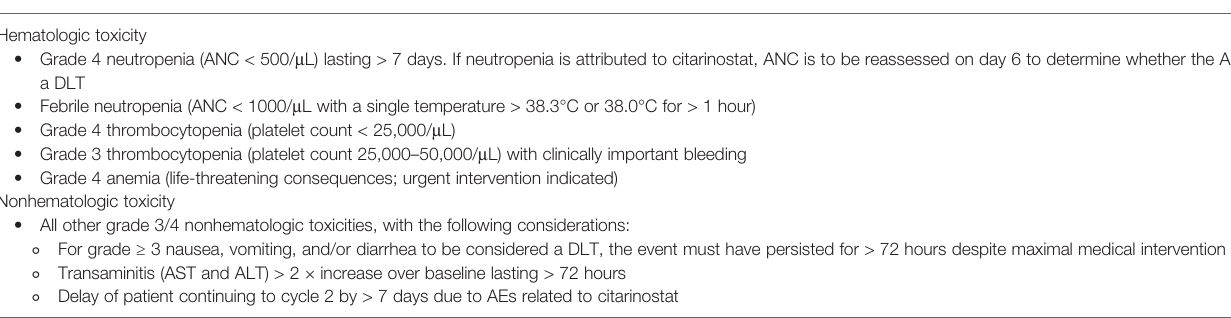
TABLE 1 | DLT de fi nitions. DLTs classi fi ed as related to